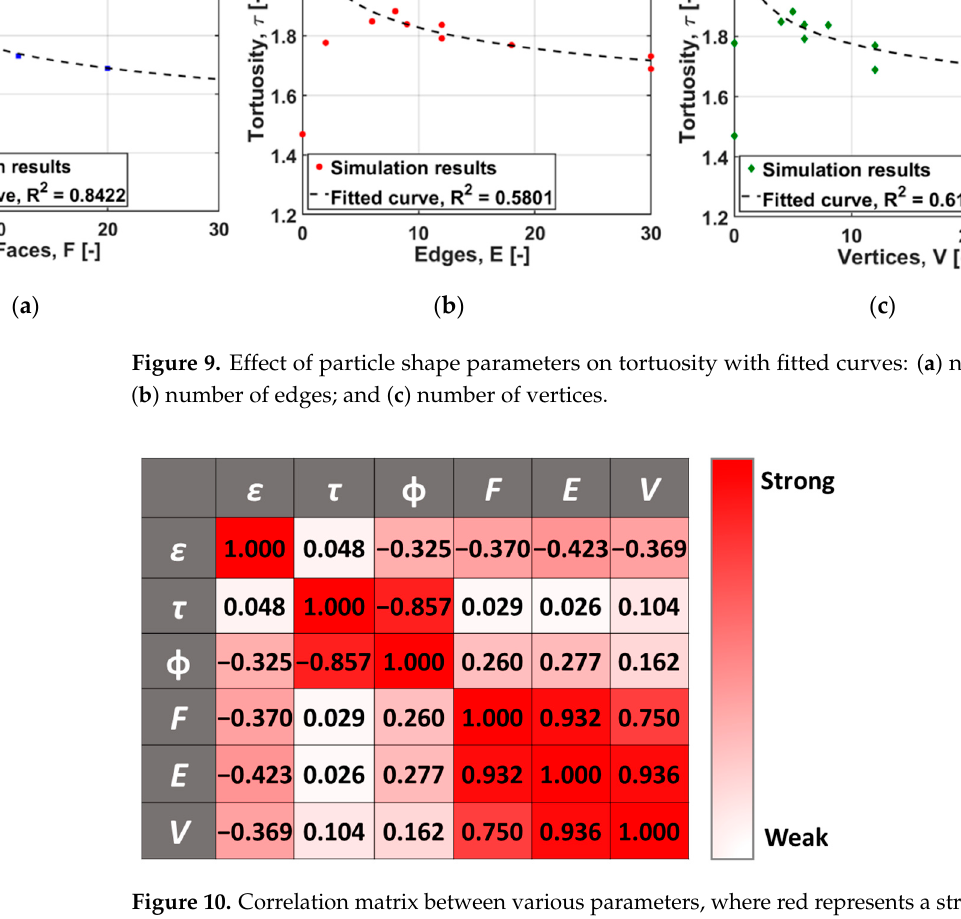
Figure 10. Correlation matrix between various parameters, where red represents a strong correla- tion.